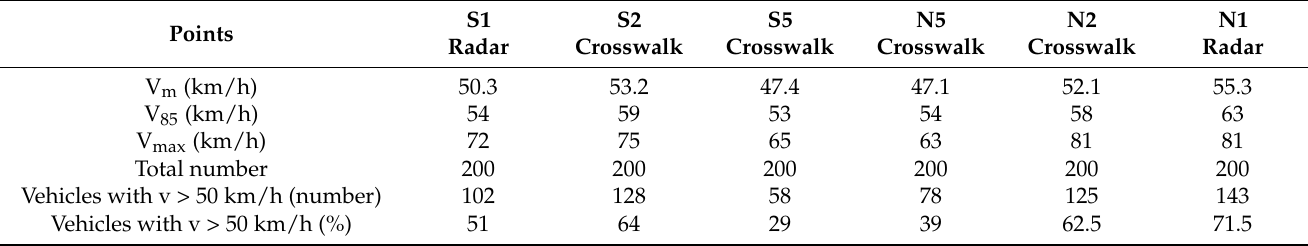
Table 3. Values of selected variables at control points in Suchowola (Poland).